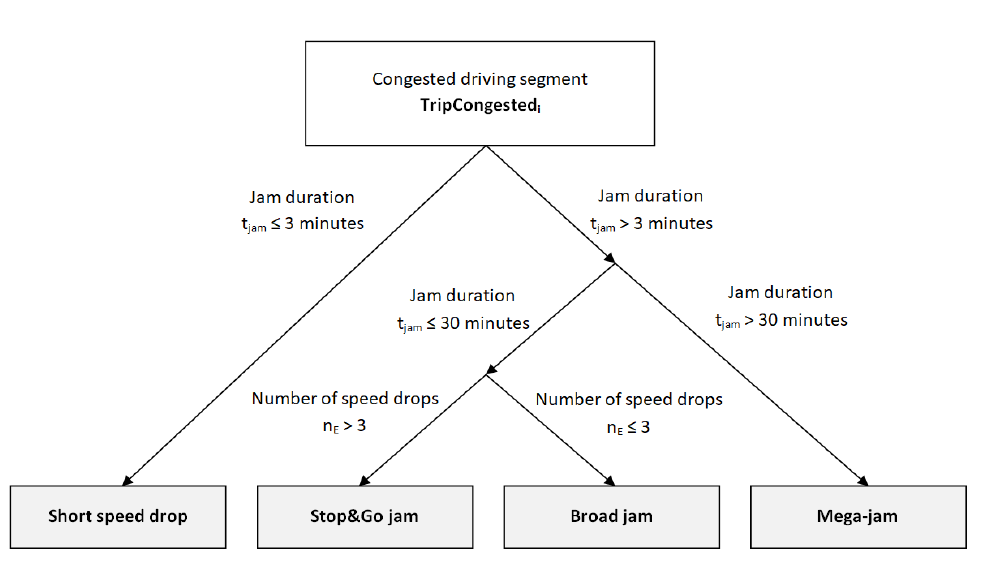
Figure 1. Classification of FCD trajectories based on definitions provided by Transver